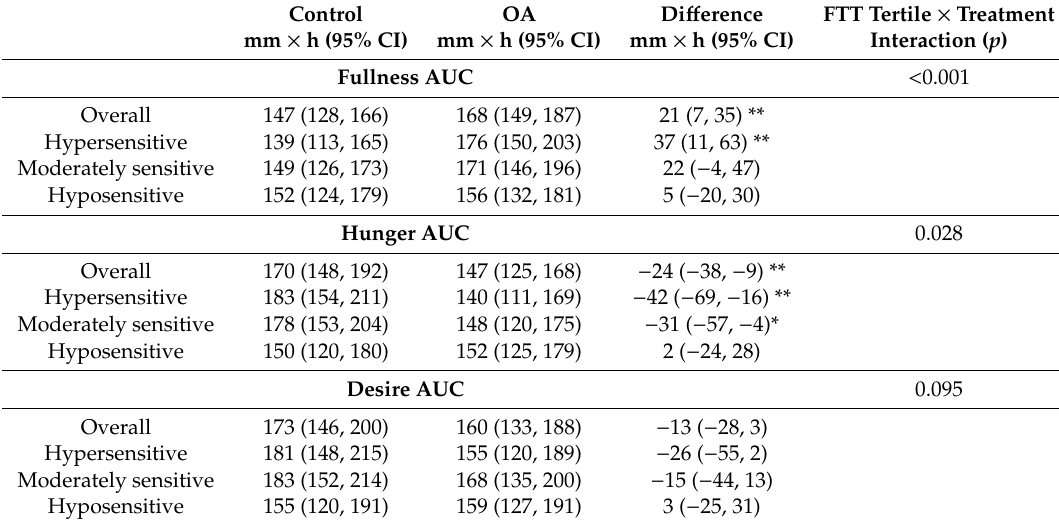
Table 2. Mean area under curves (AUCs) and differences in self-reported appetite in hypersensitive, moderately sensitive and hyposensitive individuals following mouth rinses.